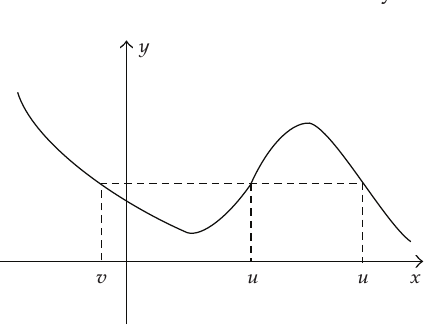
Figure 3: The picture of y (cid:2) f (cid:3) x (cid:4) /g (cid:3) x (cid:4) in (cid:3) 3 (cid:4) .